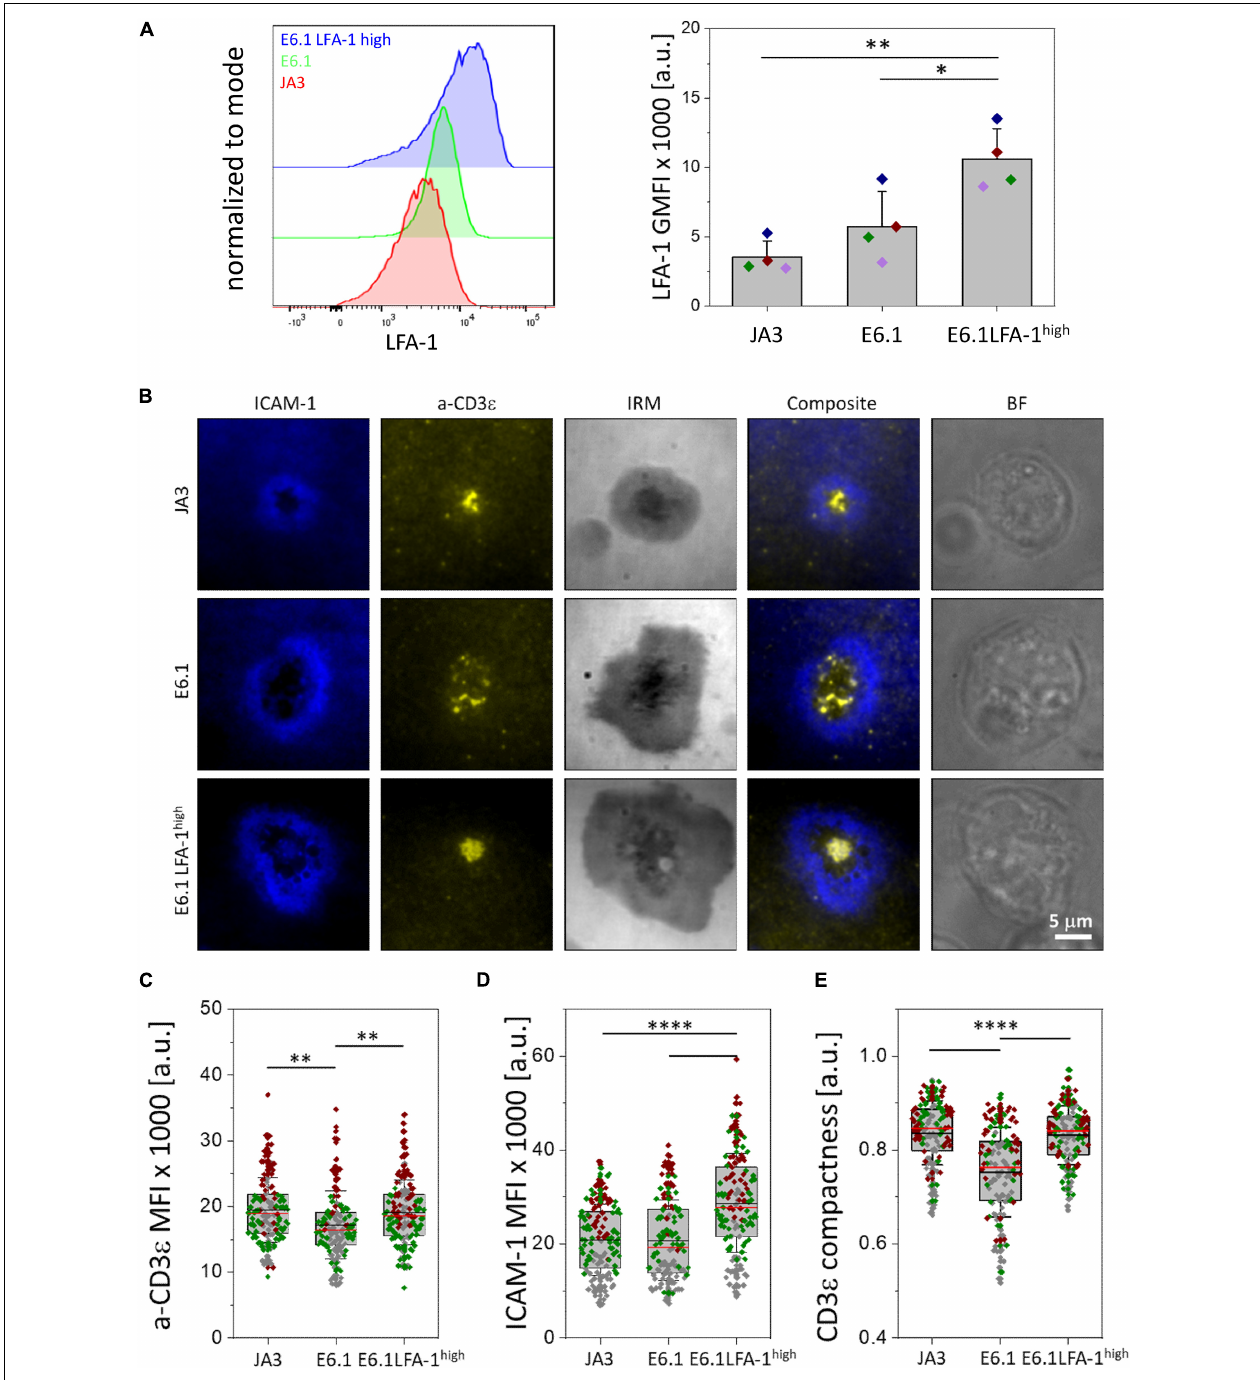
FIGURE 1 | Increasing LFA-1 expression in E6.1 cells improves TCR segregation to the cSMAC center. (A) Flow cytometric analysis of surface expression of LFA-1 (CD11a) on JA3, E6.1 and E6.1 LFA-1 high Jurkat cells. Representative FACS plots of LFA-1 are shown. The histogram shows GMFI of LFA-1 (mean ± SD). (B) Representative TIRFM images of E6.1, E6.1 LFA-1 high or JA3 Jurkat cells interacting with activating [ICAM1-AF405 (blue) + anti-CD3 ε UCHT1-CF568 Fab’ (yellow)] SLBs for 15 min. IRM, interference reflection microscopy; BF, bright field. Scale bar, 5 µ m. (C,D) Quantification of the corresponding mean fluorescent intensity (MFI) of anti-CD3 ε (C) and ICAM-1 (D) from the different Jurkat lines as in (B) . (E) Quantification of the CD3 ε compactness at the cSMAC from the experiment in (B) . Horizontal lines and error bars represent mean ± SD (black line) and median (red line). Gray boxes represent 25-75 percentile. Data are from minimum of 120 cells from three independent experiments; each dot represents a cell; each color represents an independent experiment. One-way analysis of variance (ANOVA) with Tukey’s post hoc test. Only significant differences are shown. ∗ p < 0.05; ∗∗ p < 0.01; ∗∗∗∗ p < 0.0001.